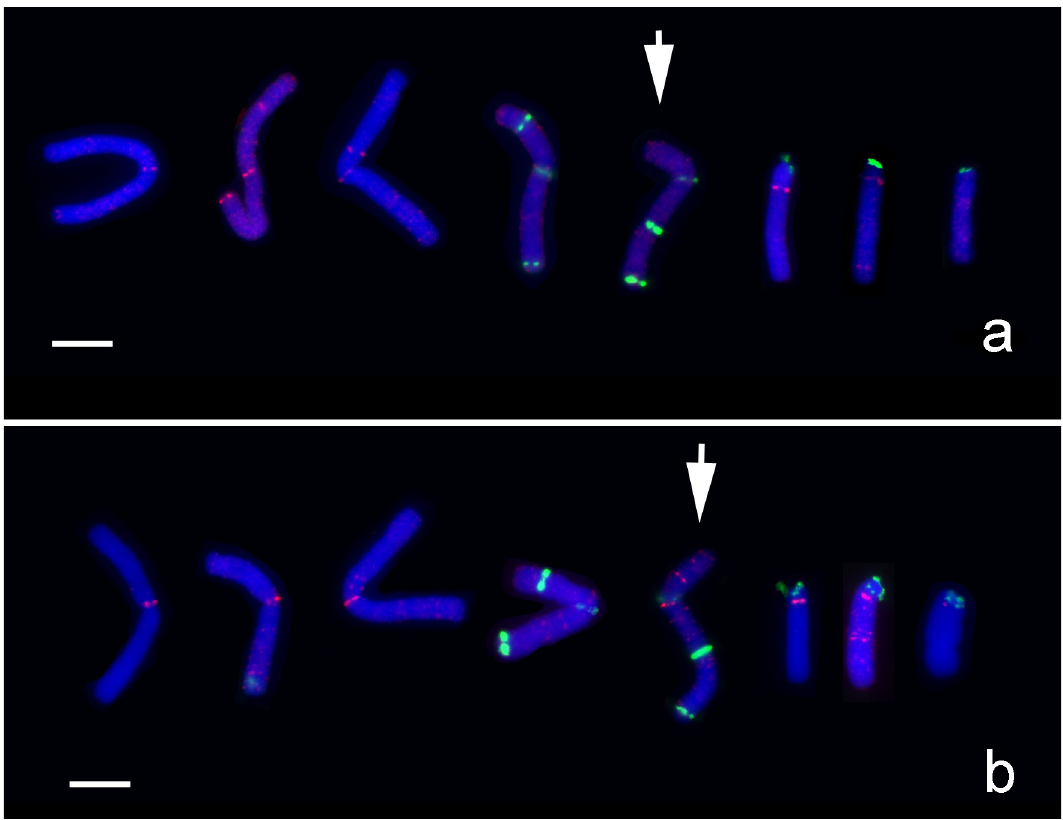
Fig 11. Karyotype of mitotic metaphase chromosomes of L . aurea with distribution of LaCenIP-1 and LaCenIP-1R-E1 repeats along chromosomes to distinguish individual chromosomes. (Scale bar = 10 μ m). Karyotype is established by individual chromosomes with clear and represented FISH signal distribution patterns. Note the similarity and difference of FISH patterns between probes on each chromosome. (a) LaCenIP-1 (red), 5S rDNA (green); (b) LaCenIP-1R-E1 (red), 5S rDNA (green). Arrow indicate the inversion M-type chromosome (arrow).